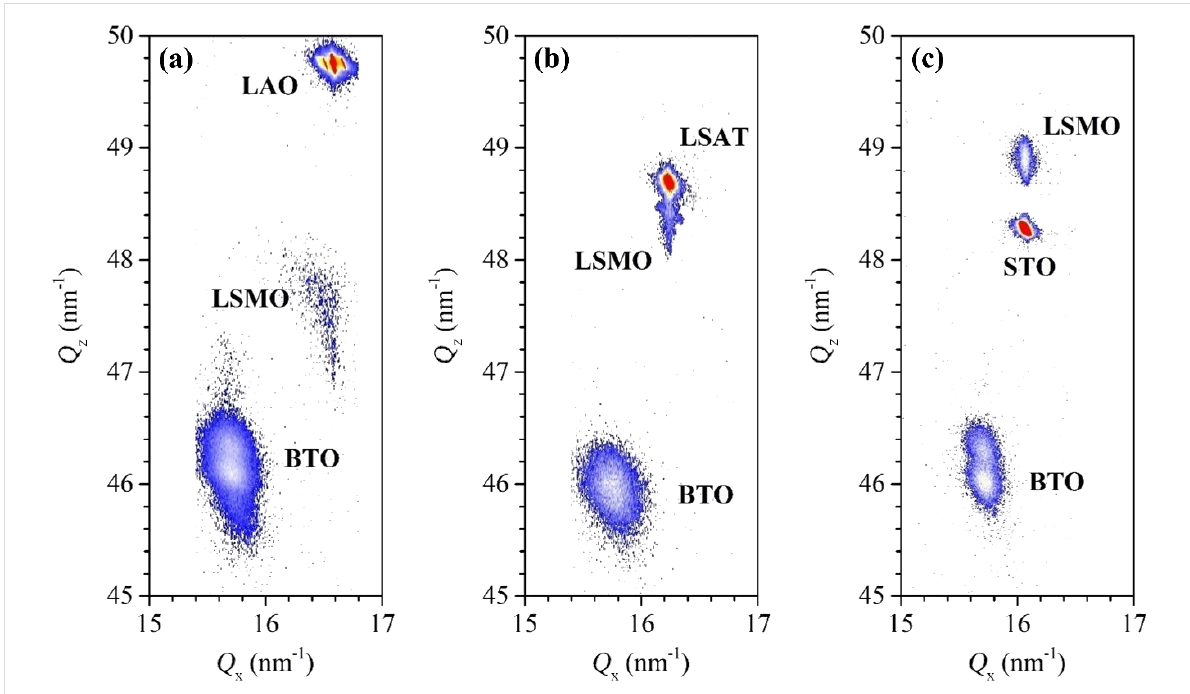
Figure 1: X-ray reciprocal space maps around the pseudo-cubic (103) Bragg reflection for the BTO/LSMO bilayers grown on (a) LAO, (b) LSAT, and (c) STO substrates.